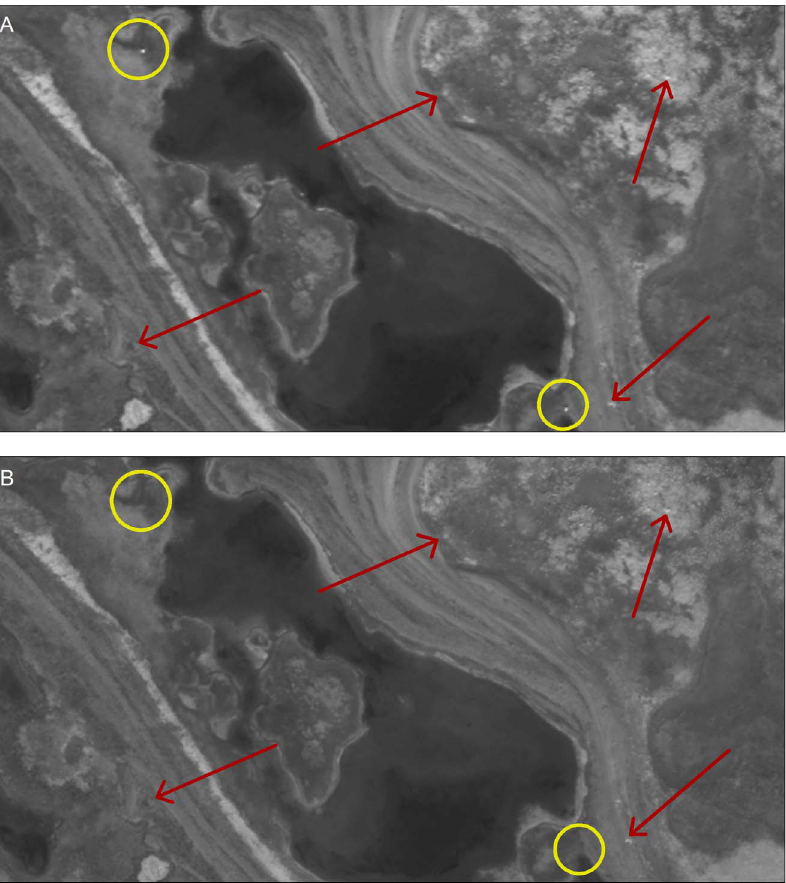
Figure 2. Example of high resolution satellite imagery used to detect polar bears. Imagery was procured from Rowley Island in Foxe Basin, Nunavut during late summer, 2012. The target imagery (a) was searched for polar bears, and the reference imagery (b) was used for comparison. Polar bears are present in the example target image but absent in the reference image (yellow circles). Landscape features that remain consistent between images, including rocks and substrate, are denoted with red arrows. Satellite imagery printed under a CC BY license, with permission from DigitalGlobe (cid:2) 2013.